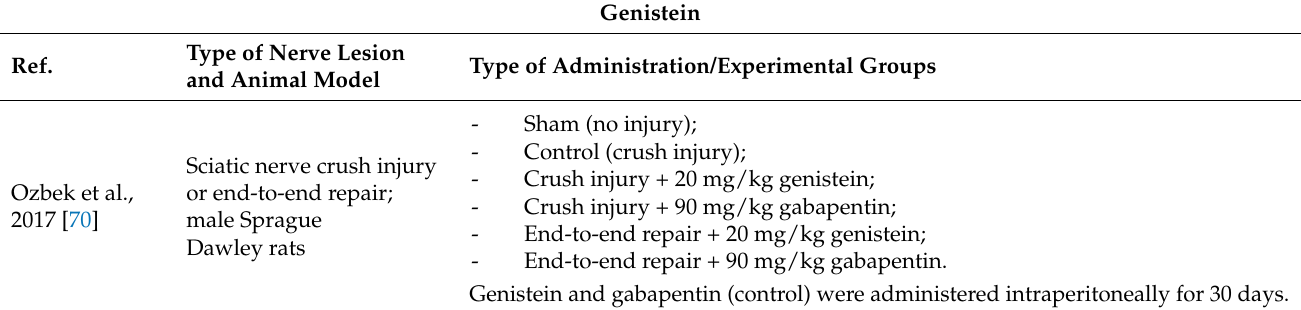
Table 4. Isoflavones: Table showing the experimental method (type of nerve injury and animal model), the dose, and method of administration of genistein.